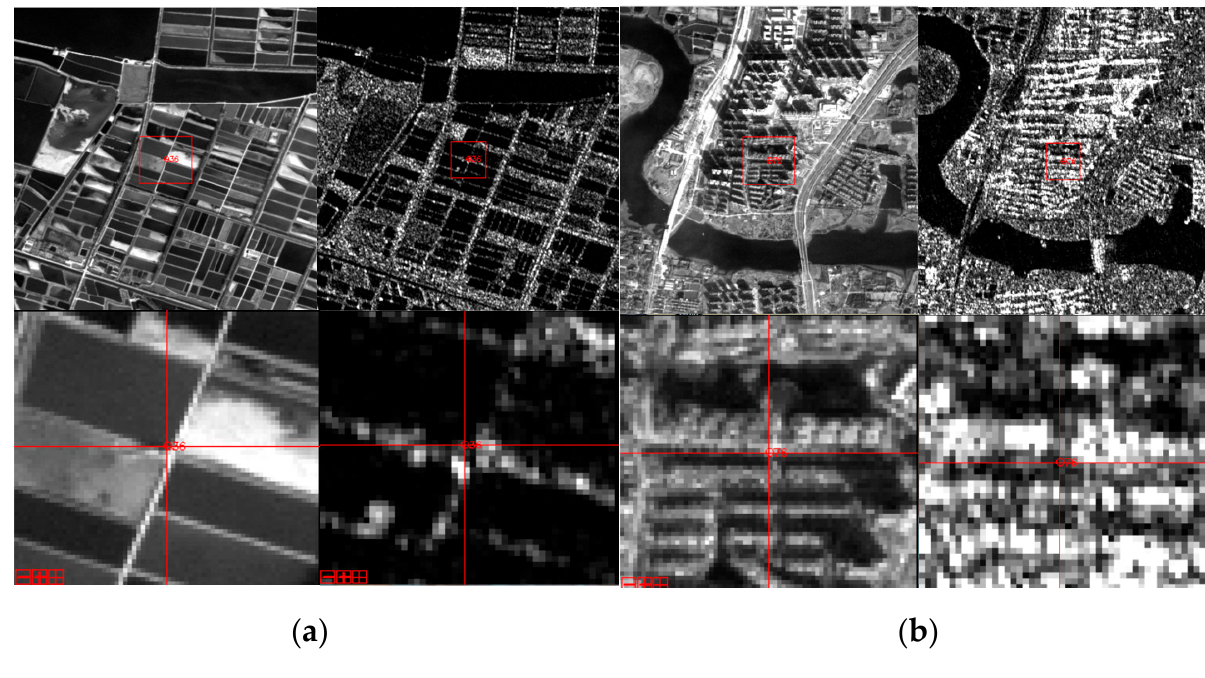
accuracy of the optical images after adjustment. At the same time, after selection and projection of the laser data, 9074 LAPs were obtained in the area of Jiangxi, and their distribution is shown in Figure 9a. The LAPs obtained after selection covers most of the image area and can provide enough LAPs as elevation control reference.